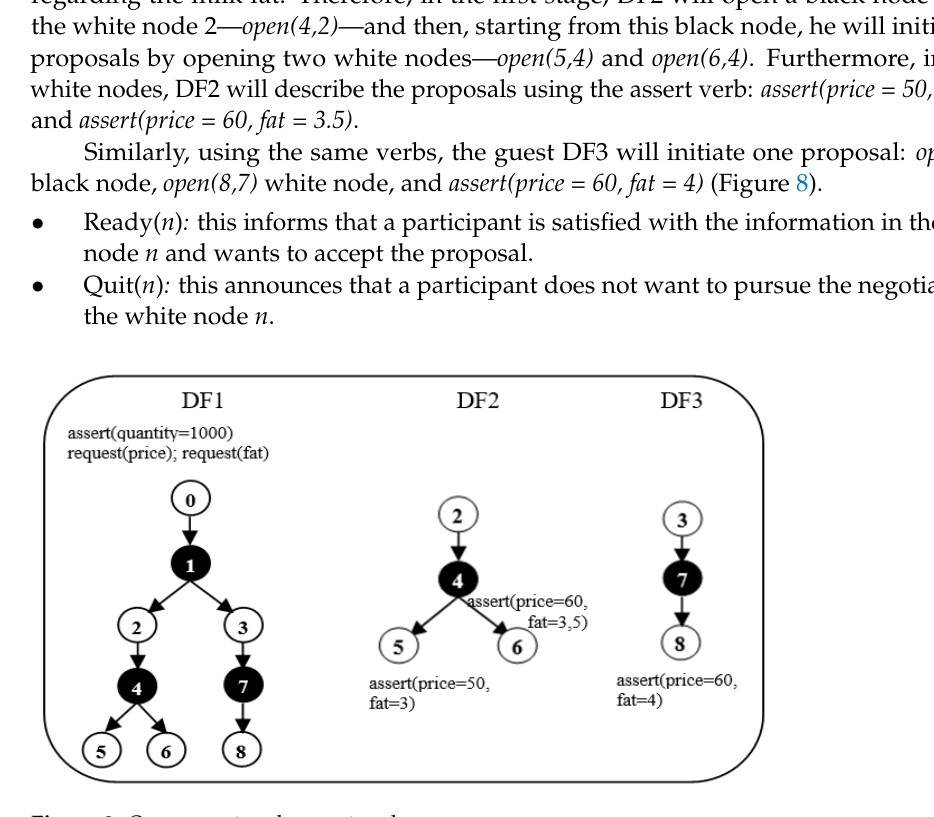
Figure 8. Open , assert and request verbs.